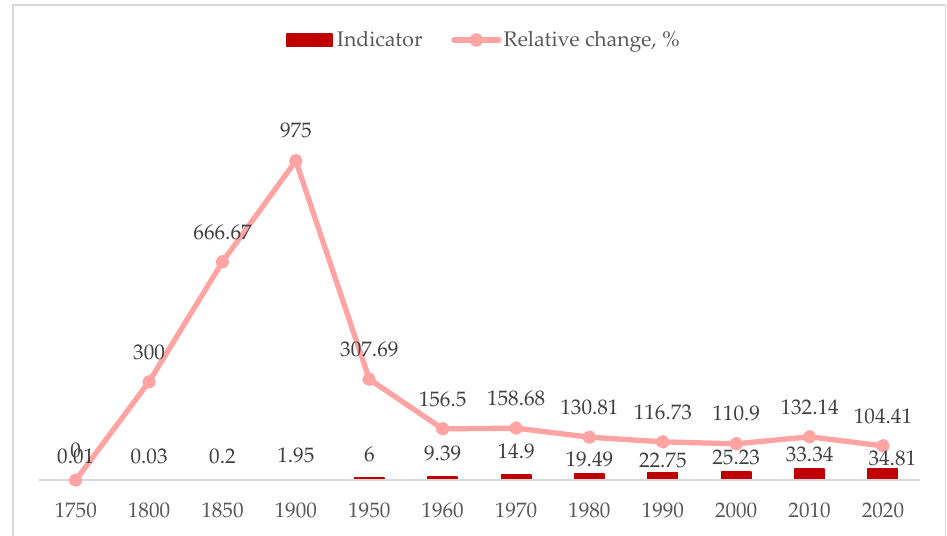
Figure 4. Historical carbon dioxide emissions from global fossil fuel combustion and industrial processes for a 50 ‐ year period (from 1750 to 1950) and for a 10 ‐ year period (from 1960 to 2020), in billion metric tons [24].